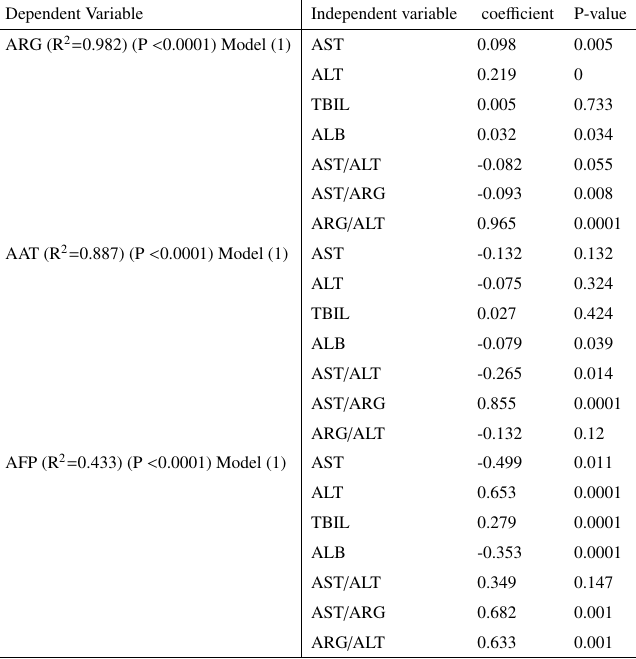
Table 2. Multiple regression analysis to identify association of serum ARG, AAT and AFP with some routine analyses and enzymes ratios in all studied